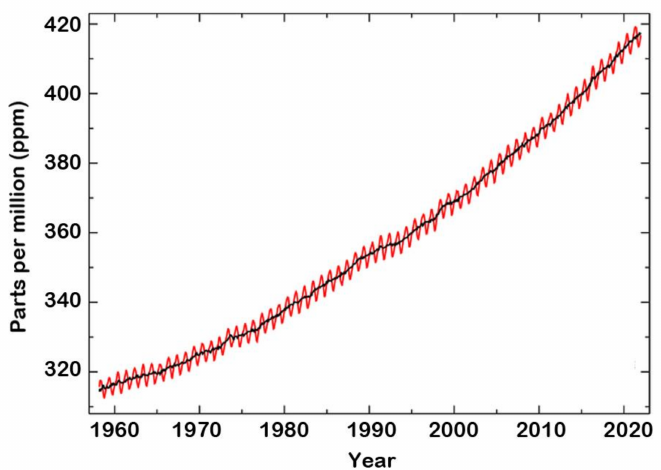
Figure 7. Global concentrations of CO 2 in the atmosphere during the period 1960–2021. Elaboration from reference [42]. © Global Monitoring Laboratory (GML) of the National Oceanic and Atmospheric Administration (NOAA).